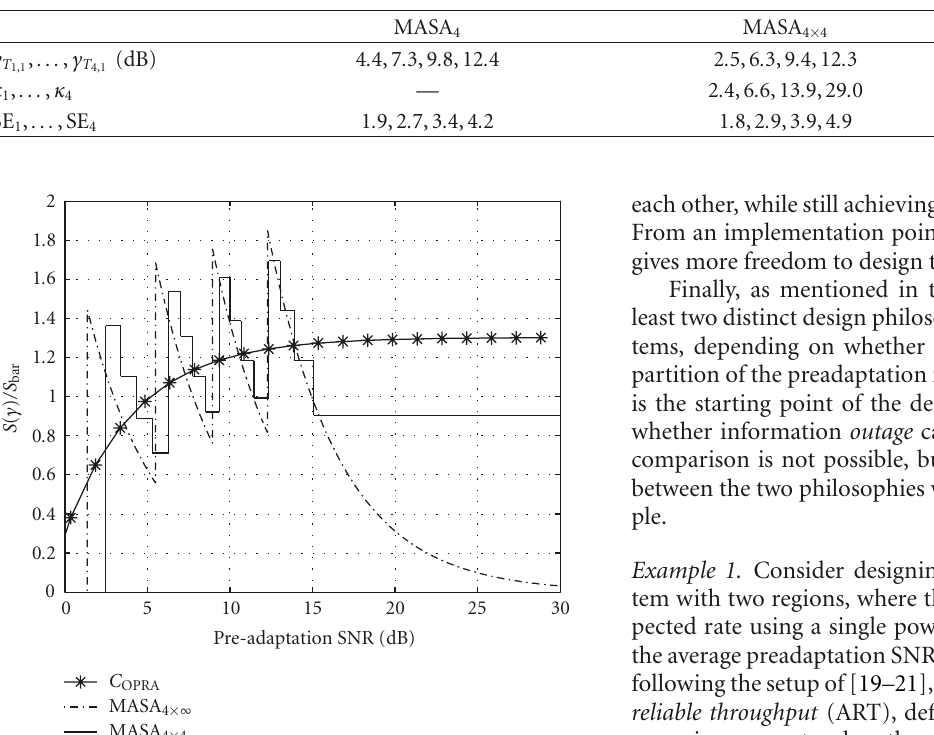
Table 1: Rate and power adaptation for four regions, γ = 10dB.